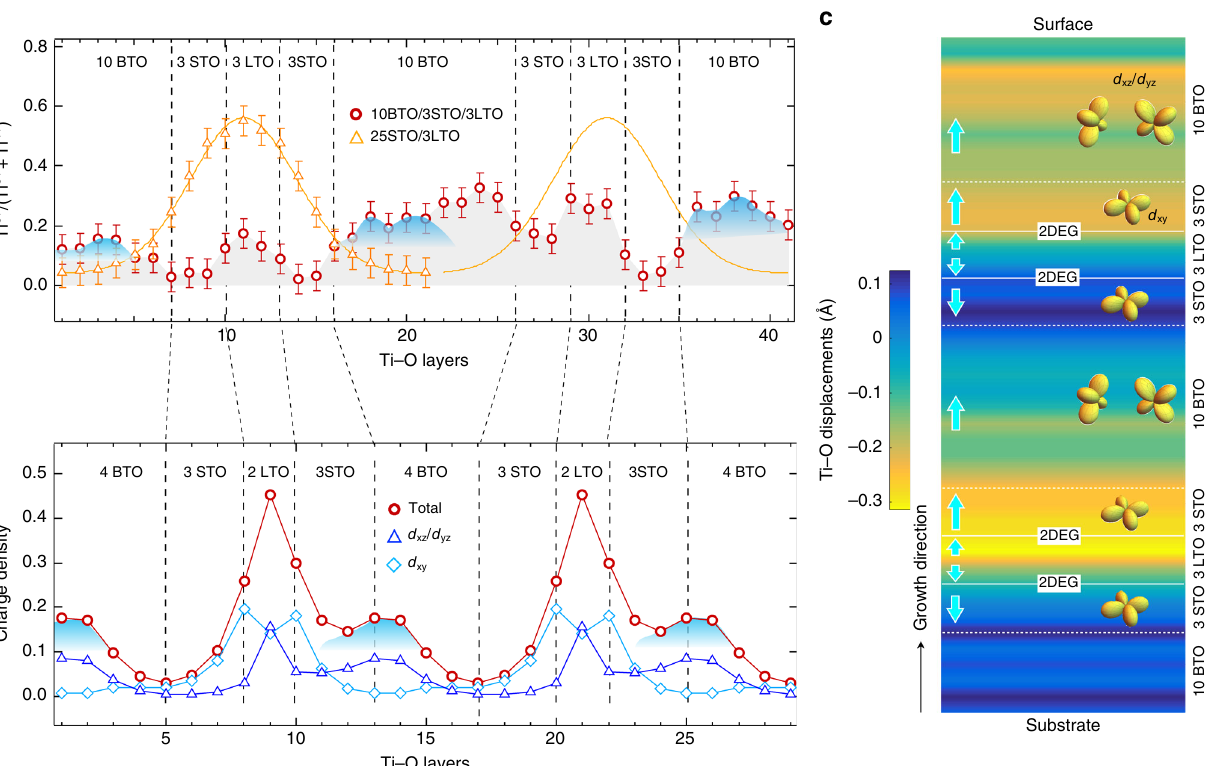
Fig. 4 Modulation of electric polarization, charge distribution, and orbital symmetry. a Experimentally layer-resolved charge distribution of 10BTO/3STO/ 3LTO (red circles) and reference sample 25STO/3LTO (yellow triangles) measured by STEM/EELS. It is noted the yellow solid lines are guidelines for clarity. Here the error bar indicates the standard deviation between experimental and fi tting spectra. Blue shadows (in a , b ) indicate the anomalous charge distribution in BTO layers. b Calculated orbitally resolved charge distribution for each TiO 2 layer in 4BTO/3STO/2LTO. Red circles indicate total projected density of states, whereas blue triangles and light-blue rhombuses label the contribution from d xz / d yz and d xy orbitals, respectively. c Illustration of coexisting electric polarization and two-dimensional electron gas with theoretically proposed in-plane d xy state as the preferential occupation. The image is plotted based on experimental Ti – O polar displacements (Fig. 3d). White solid lines schematically indicate the positions of two-dimensional electron gases, whereas cyan arrows mark the direction switching of Ti – O displacements. The strength and direction of polarization are labeled by the color map from blue to